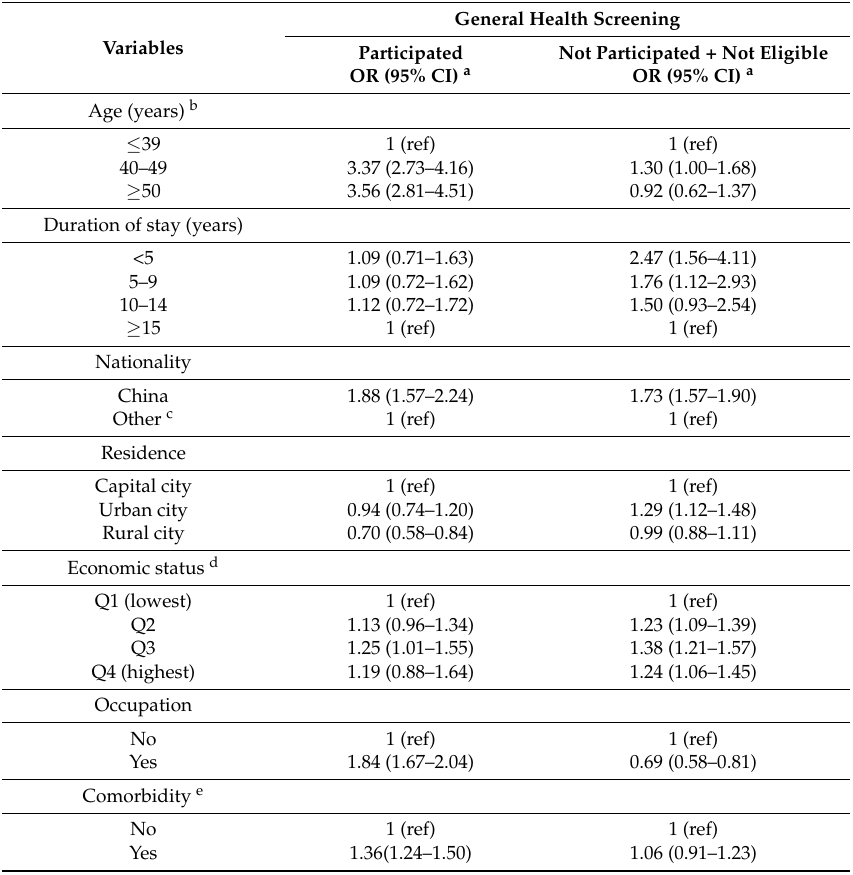
Table 3. The association between cervical cancer screening participation and related factors stratified by general health